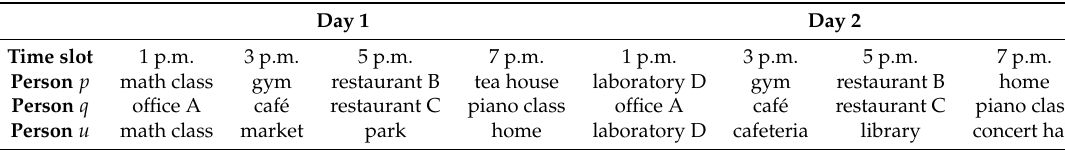
Table 3. Behaviors of Persons p , q , and u .